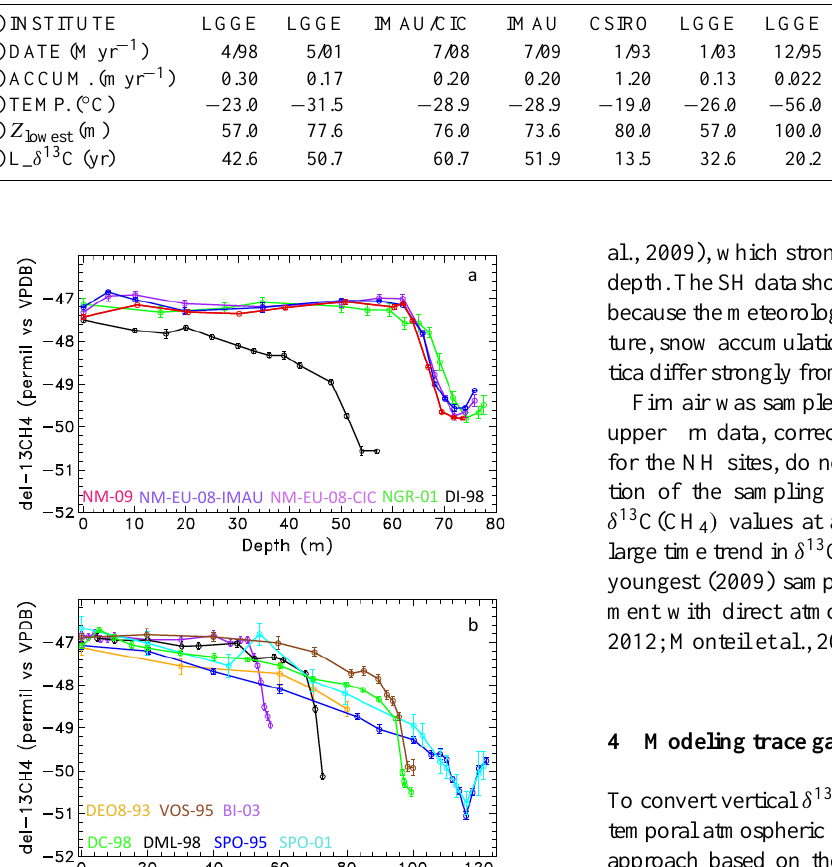
Table 1. Information on the eleven firn air pumping sites used in this paper. The NH sites are Devon Island (DI), North GRIP (NGR), NEEM- 2009 (NM-09), NEEM-EU hole (NM-EU-08). The SH sites are DE08-2 (DE08), Berkner Island (BI), Vostok (VOS), Dronning Maud Land (DML) and Dome Concordia (DC) (Bräunlich et al., 2001), South Pole 1995 (SPO-95) and South Pole 2001 (SPO-01) (Sowers et al., 2005). (1) Institute where the measurements used in this study were performed. (2) Date of the firn sampling campaigns. (3) Snow accumulation rate. (4) Annual mean temperature. (5) Z lowest is the depth of the lowest measurement for δ 13 C. (6) Estimated length of the δ 13 C scenario. SITES